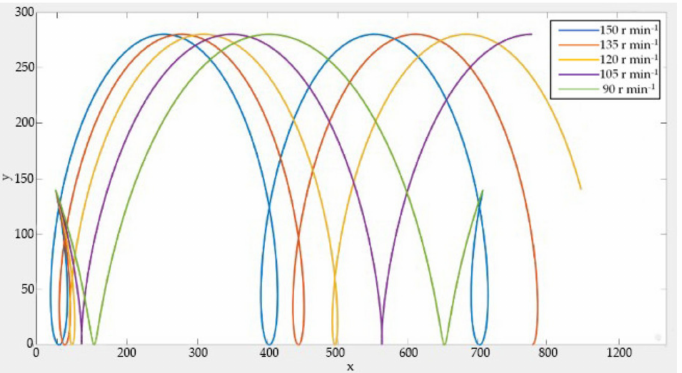
Figure 14. Relationship between the influence of the drilling speed on the